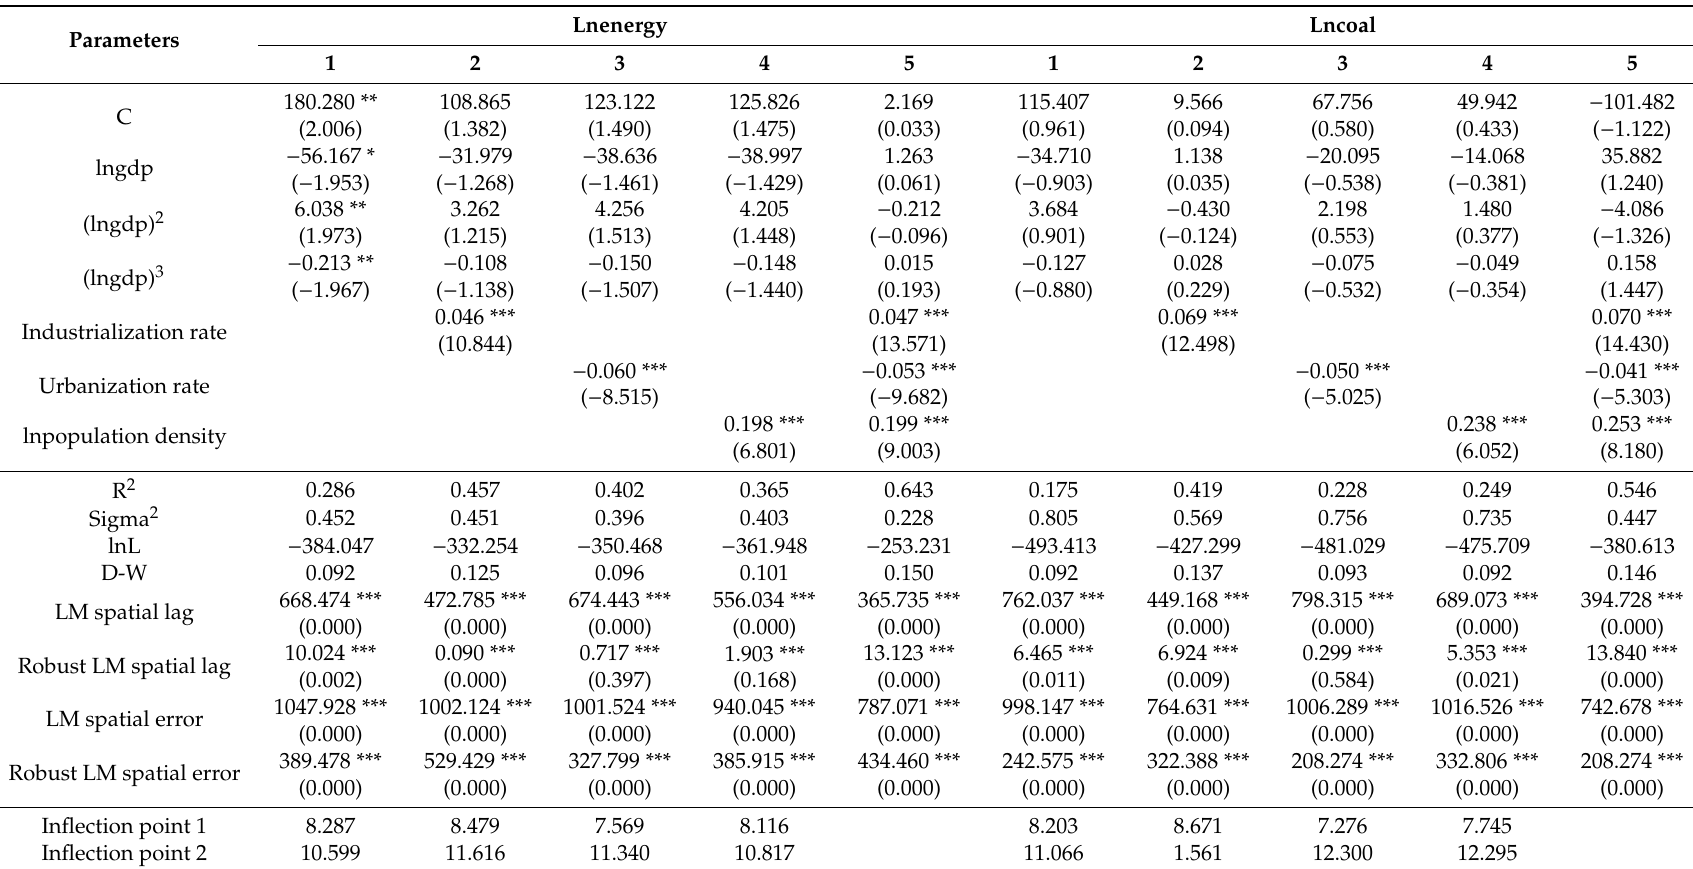
Table 4. Energy consumption environmental Kuznets curve (EKC) panel data estimation